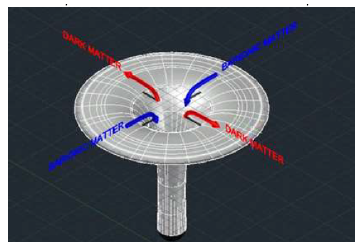
Figure 1. Dark matter production inside a black